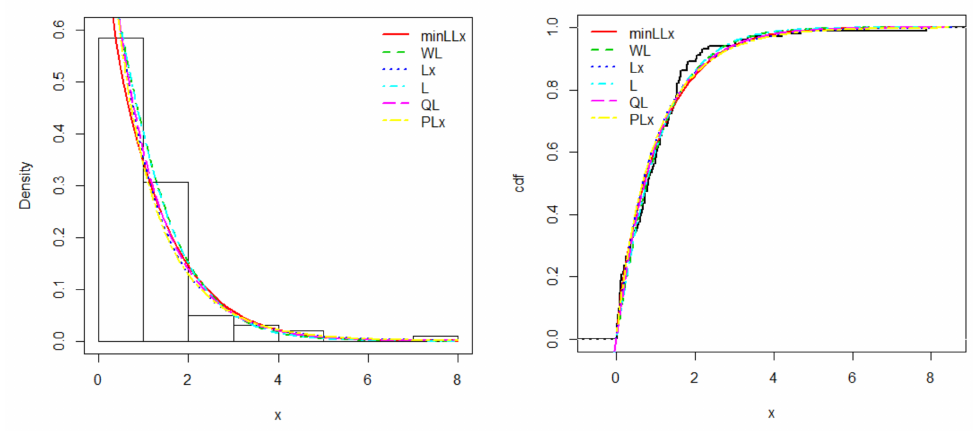
Figure 3. Estimated pdf and cdf plots of the minLLx distribution for the first data set.